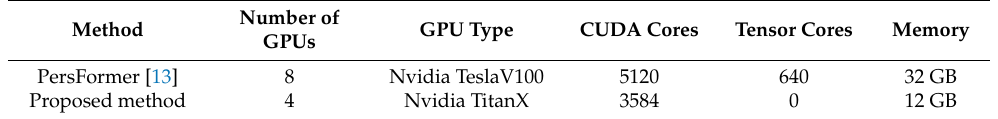
Table 4. Computational resources of proposed method and